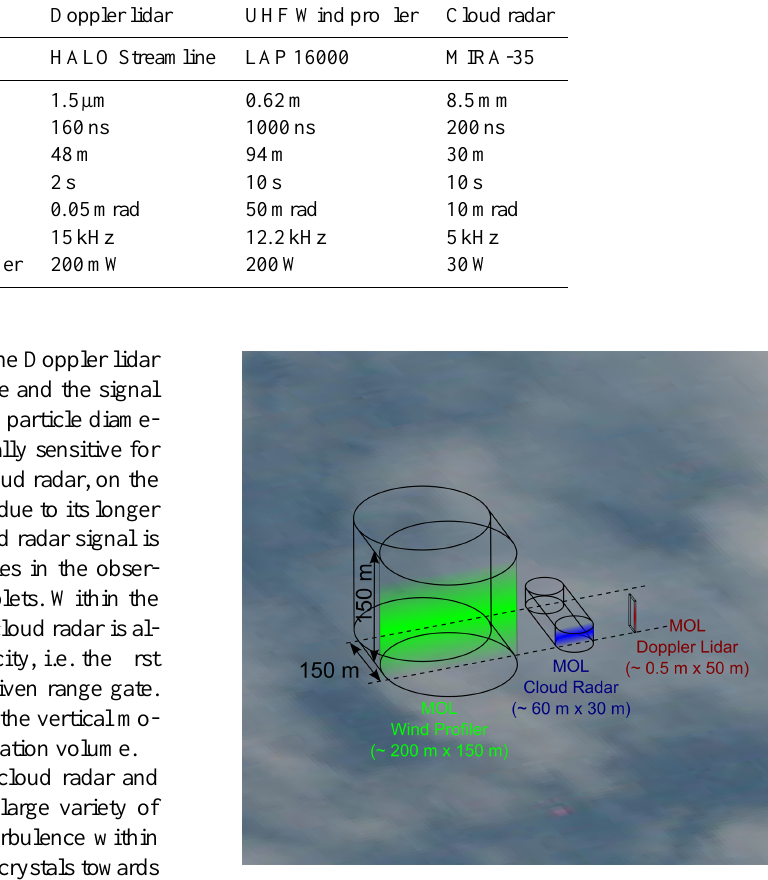
Figure 2. Comparison of observation volumes of Doppler lidar (red), cloud radar (blue) and wind profiler (green). Beam diame- ter times folded pulse length is given in brackets below the sys- tem names. The length interval of 150m, indicated by two dashed lines, is the displacement of the cloud during an integration time of 10s, when moving with an advection speed of 15ms − 1 . In the background, a representation to scale of the altocumulus at 4000m height is shown. In this figure, only the sizes of the observation volumes are shown. In reality, the observation volumes of cloud radar and Doppler lidar would overlap from about 1000m height upwards. One pulse of the wind profiler fills a factor of 10 4 ... 10 5 more space than the Doppler